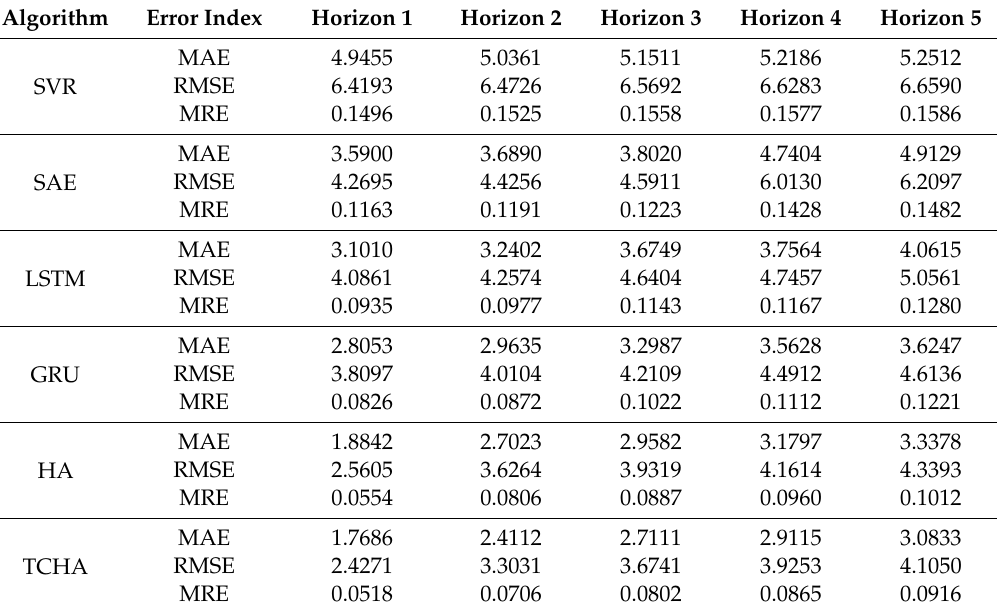
Table 2. Performance of di ff erence prediction horizons (Tonghui